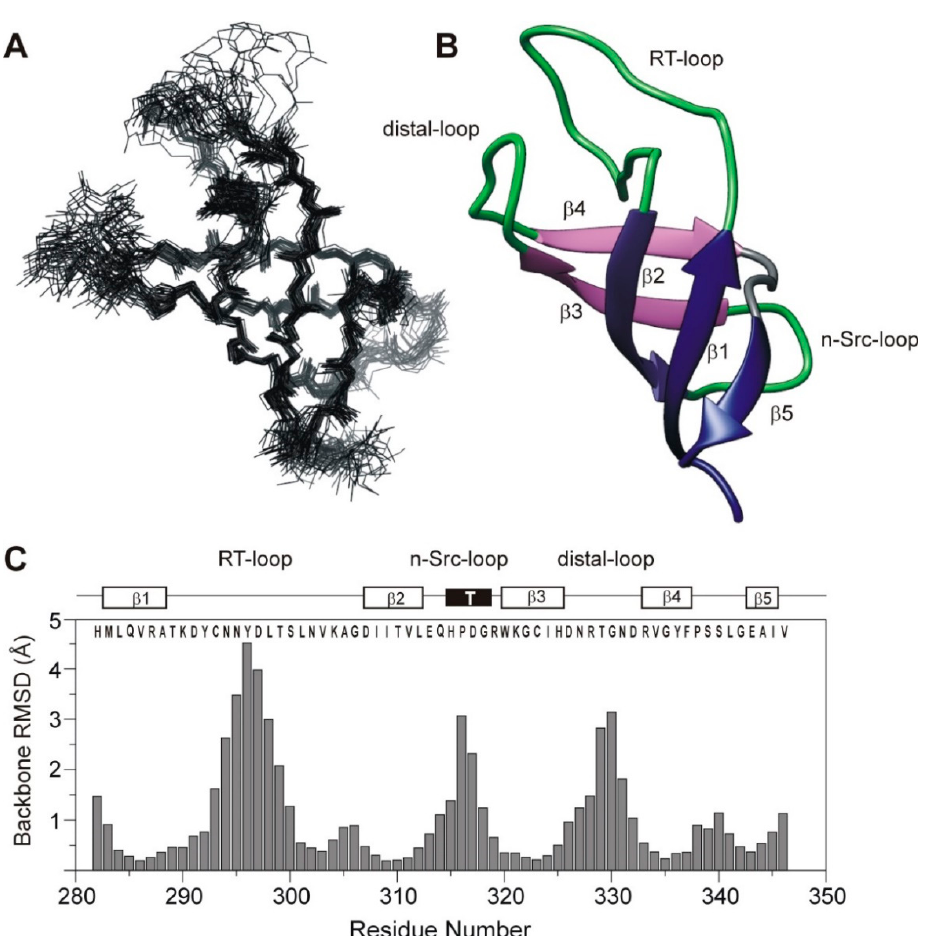
Figure 3. Results of NMR structure calculation. ( A ) Superposition of the 30 lowest-energy conformations obtained for the backbone atoms of the SH3 domain of human Caskin1. ( B ) Ribbon diagram of the most representative member of the lowest-energy structural ensemble. Secondary structure elements are labeled. Beta-strand β 2 is shared by the front ( β 5, β 1, β 2) and back ( β 2, β 3, β 4) beta-sheets. ( C ) Average backbone RMSDs from the mean of the 30 lowest-energy conformations of the SH3 domain of human Caskin1. Secondary structure elements along the amino acid sequence are indicated at the top. Table 1. Statistics and stereochemical quality of the lowest-energy NMR structural ensemble (30 structures) of the human Caskin1 SH3 domain in aqueous buffer (20 mM K-phosphate, 100 mM the Protein Structure Validation Suite (PSVS). Glycines, prolines, and residues in disordered re- gions were excluded from the Ramachandran analysis.